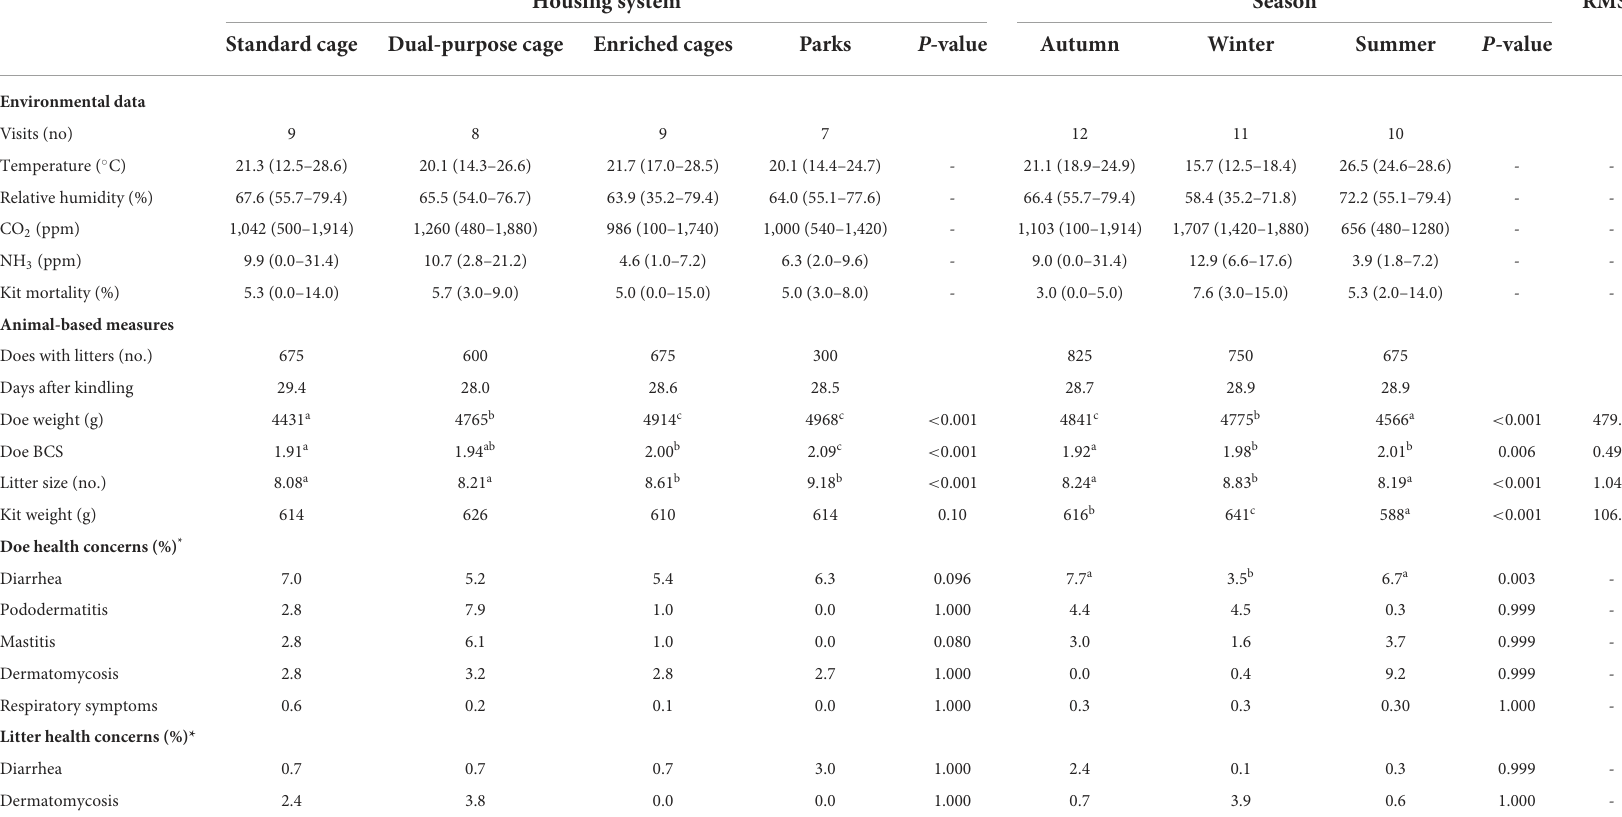
TABLE 4 Results of the pre-weaning visit in farms with different housing systems across three seasons: environmental (means and intervals) and animal-based measures (means) in reproducing does and kits. Housing system Season RMSE Standard cage Dual-purpose cage Enriched cages Parks P- value Autumn Winter Summer P